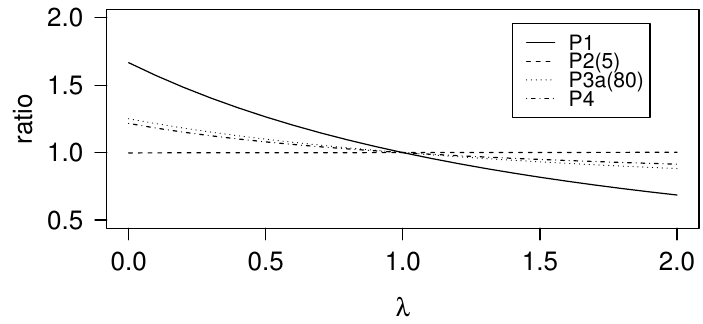
Figure 6. Extra-mortality assumption: sensitivity analysis.